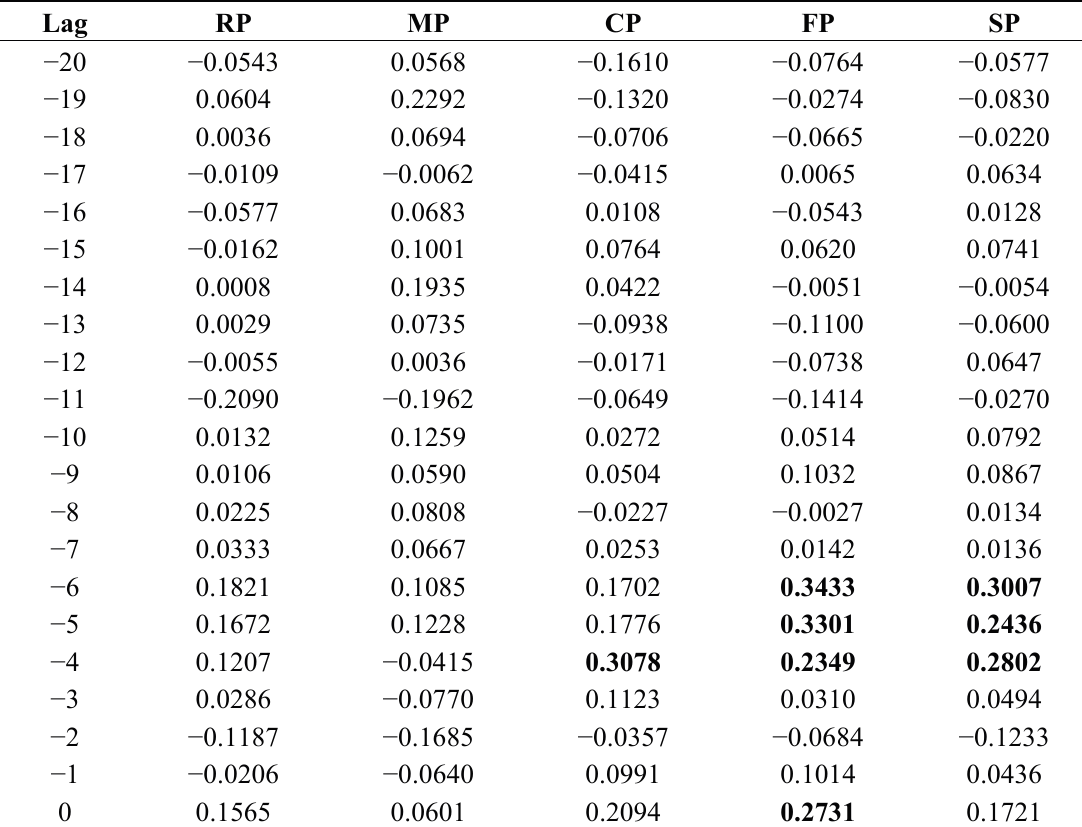
Table 5. Correlation coefficients between the Pacific Decadal Oscillation (PDO) and the annual rainfall time series for the Pampa